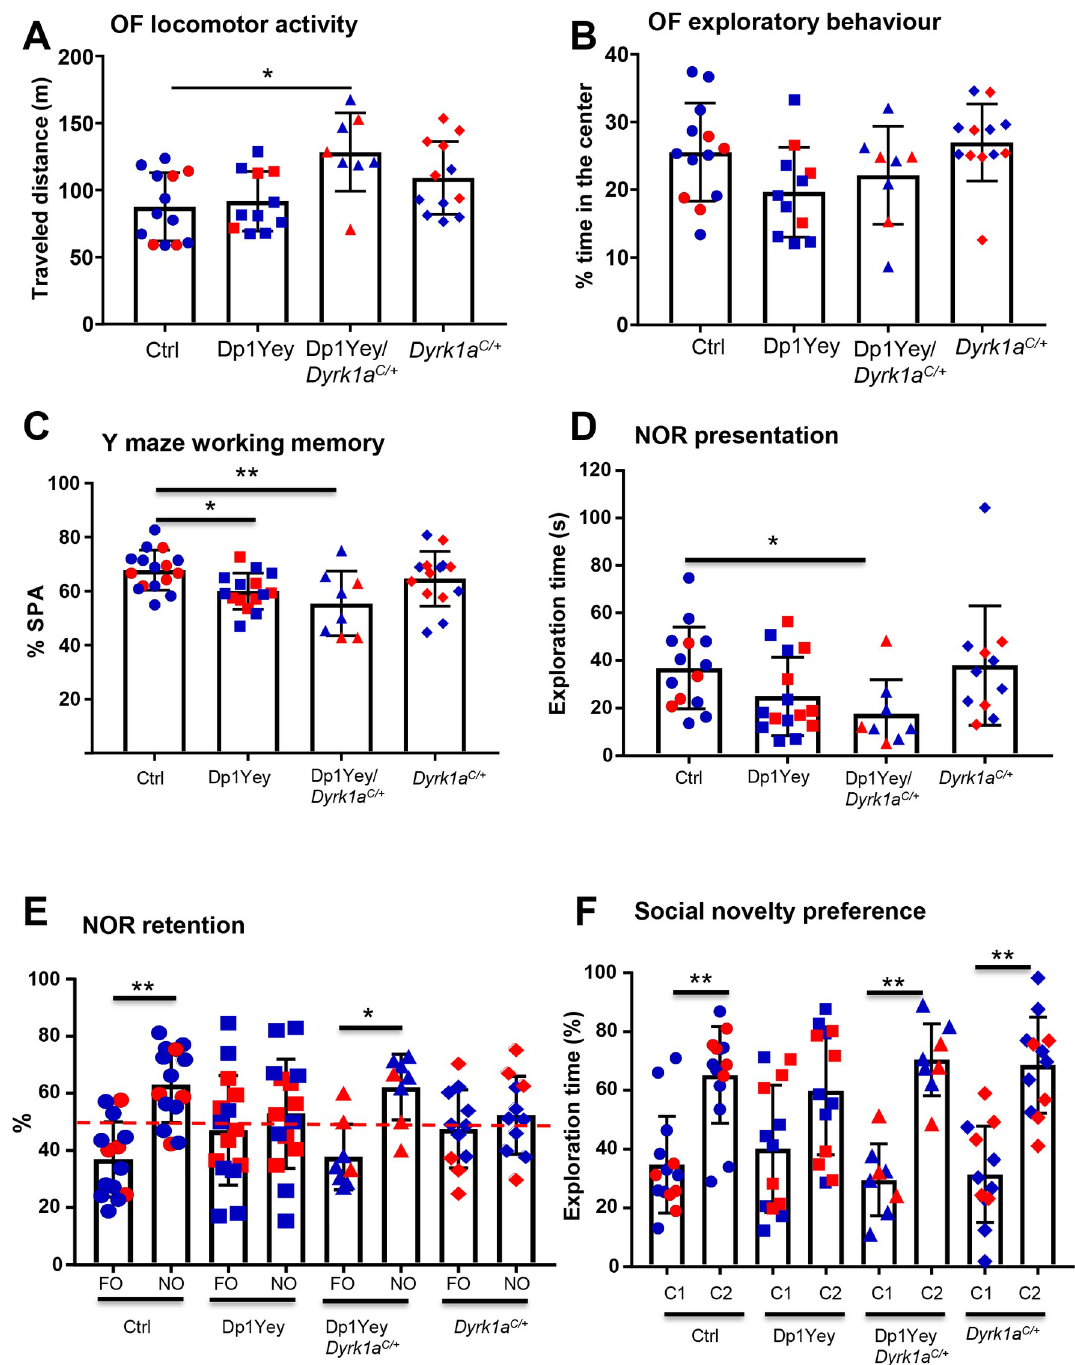
Fig 5. Consequence of the normalization of Dyrk1a in glutamatergic neurons of Dp1Yey mice on animal cognition. (A) The total distance travelled in the open field during a 30 min session is significantly increased in the Dp1Yey/ Dyrk1a C/+ mice compared to the control mice (Kruskal-Wallis One Way Analysis of Variance on Ranks, p = 0.009 with Dunn’s post hoc multiple comparison procedures versus control, Dp1Yey/ Dyrk1 C//+ vs control, p = 0 . 007) . (B) Percentage time spent in the center of the OF does not vary between genotypes (One way ANOVA, F(3, 40) = 2.76, p = 0.054). (C) Percentage of spontaneous alternation of the mice during a 5 min session in a Y-maze. Lower percentage of alternation was found in Dp1Yey mice and in Dp1Yey/ Dyrk1a C/+ indicating a deficit in working memory in Dp1Yey mice that is not rescued in Dp1Yey/ Dyrk1a C/+ mice (One way ANOVA, Holm-Sidak method for multiple comparisons versus control group, F(3,49) = 4.3, p = 0.009, Dp1Yey vs control q = 2.48, p = 0.03, Dp1Yey/ Dyrk1a C/+ q = 3.24, p = 0.006). (D-E) Novel object recognition was assessed with 24 hours time laps. (D) Time spent exploring the two identical objects